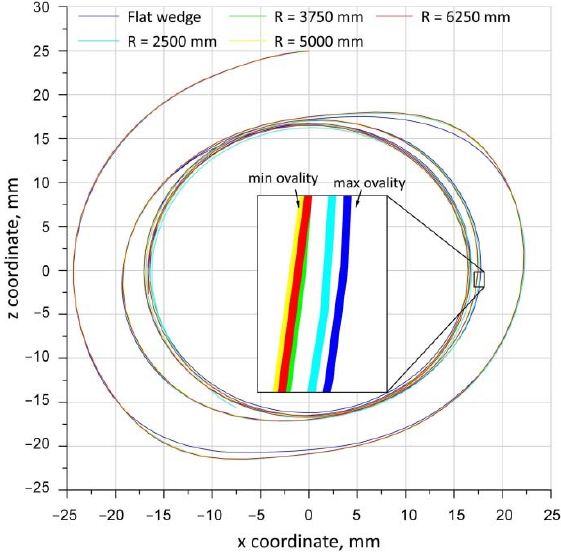
Figure 20. Trajectories of movement of point P1 for different wedge ‐ tool geometries.